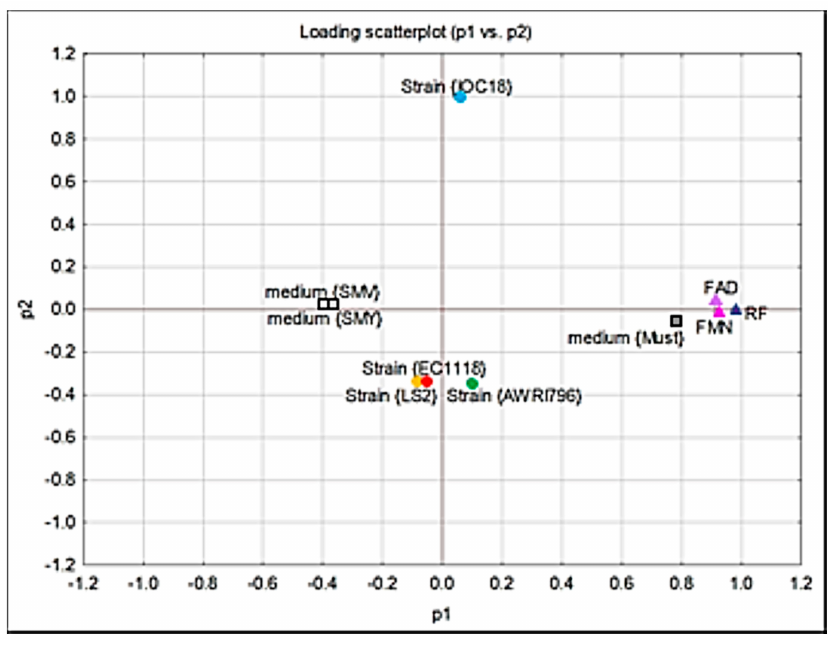
Figure 5. Scatter plot of the PCA analyses regarding the intracellular content of FDs. Table 2. Production of molecular RF (ng/10 6 cells) during the fermentations in SMV, SMV+RF, and Chardonnay must. The results were divided into 10 13 RF molecules in order to normalize the values. Time (d) EC1118 IOC18-2007 LS2 AWRI